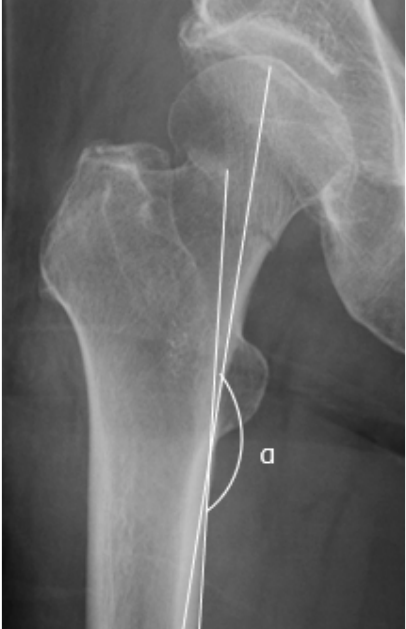
Figure 2. Garden alignment index using a preoperative anteroposterior radiograph. The angle of GAI is denoted by ⍺ .